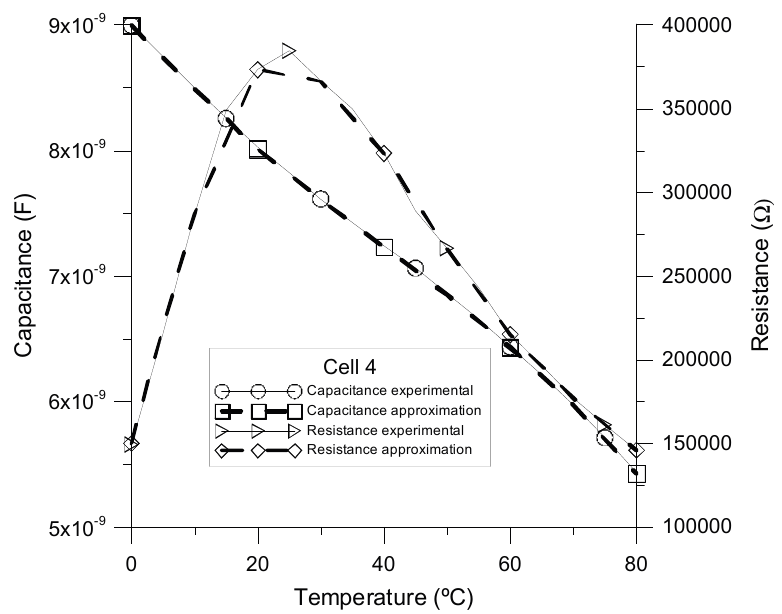
Figure 9. Experimental (solid lines) and simulated (dashed lines) values of the capacitance and resistance of homeotropic MLC-6290 cell.